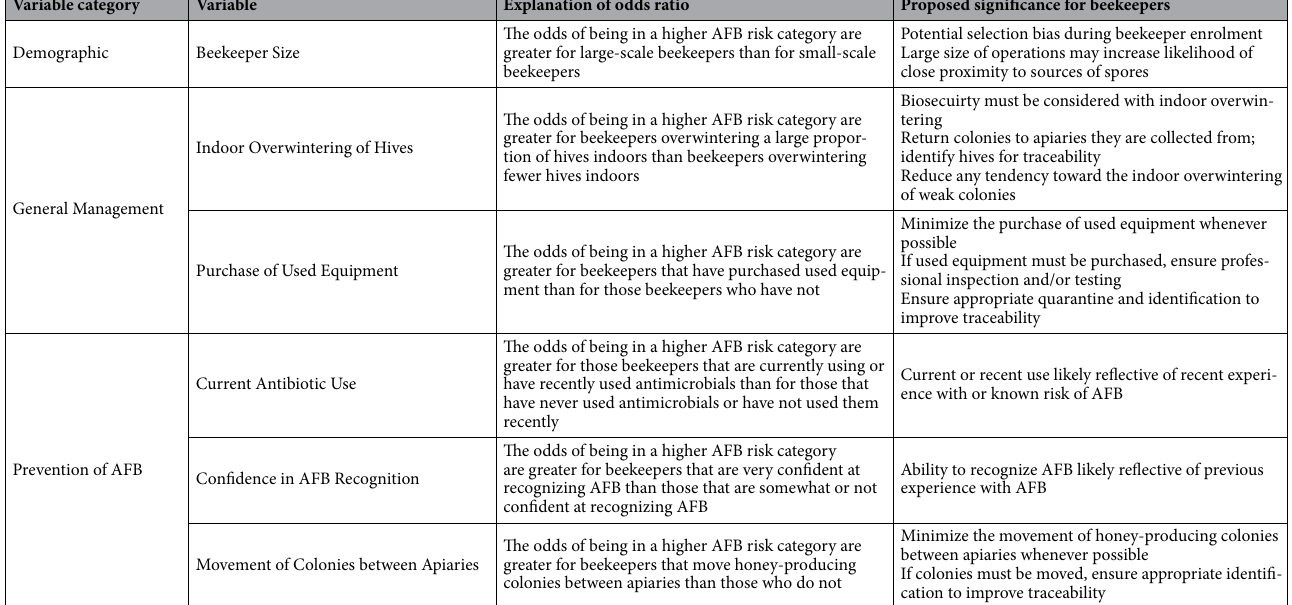
Table 3. Proposed significance of variables in final model of prediction of future AFB